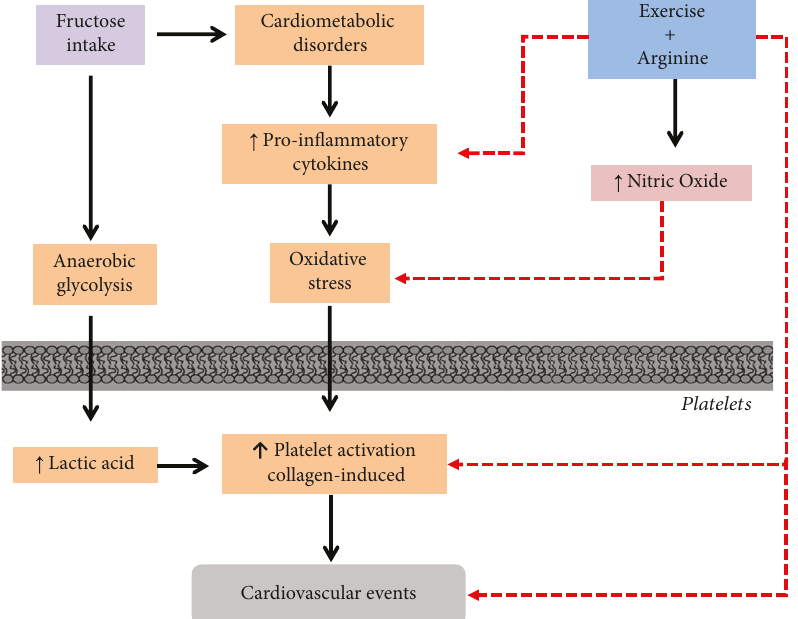
Figure 5: The hypothesis of inhibitory e ff ect of exercise and arginine association in platelet activation of rats under high risk to develop metabolic syndrome. The high fructose intake triggers several cardiometabolic disorders, re fl ecting in an increase in lactic acid, proin fl ammatory cytokines, and oxidative stress. These events contribute to collagen-induced platelet activation. In addition, the increase in lactic acid produced by anaerobic glycolysis in platelets might be a mediator in platelet hyperaggregability. On the other hand, aerobic training associated with arginine supplementation decreases platelet hyperaggregability collagen – induced probably related to enhancement of NO production, inhibition of proin fl ammatory cytokines and oxidative stress, and fi nally inhibition of platelet